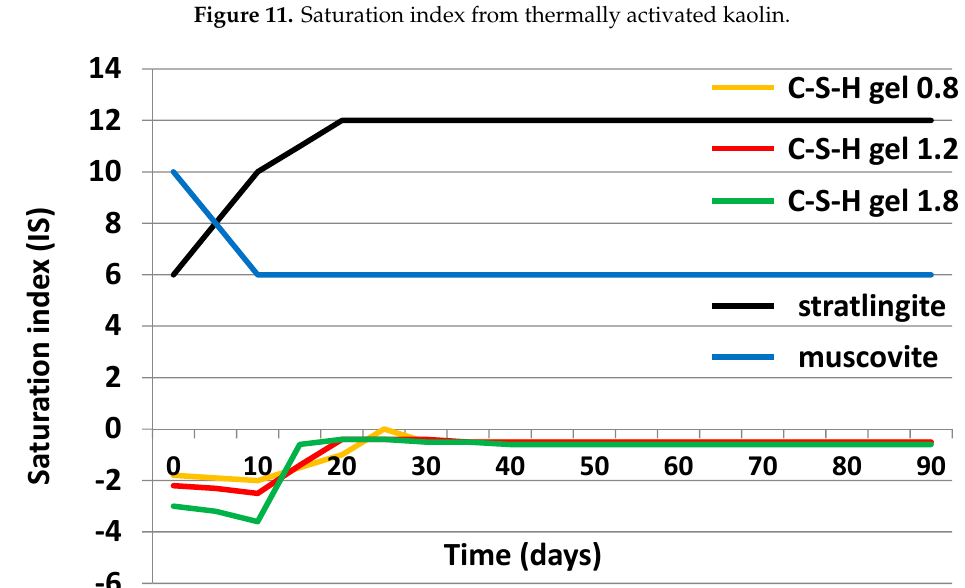
Figure 11. Saturation index from thermally activated kaolin.